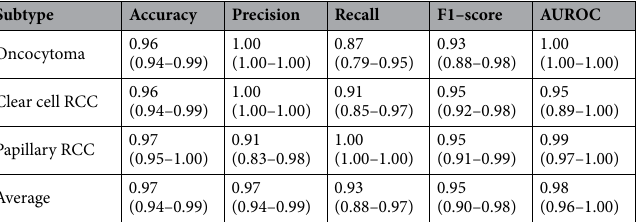
Table 3. Model’s performance metrics and their 95% confidence intervals on 79 biopsy whole-slide images from DHMC.